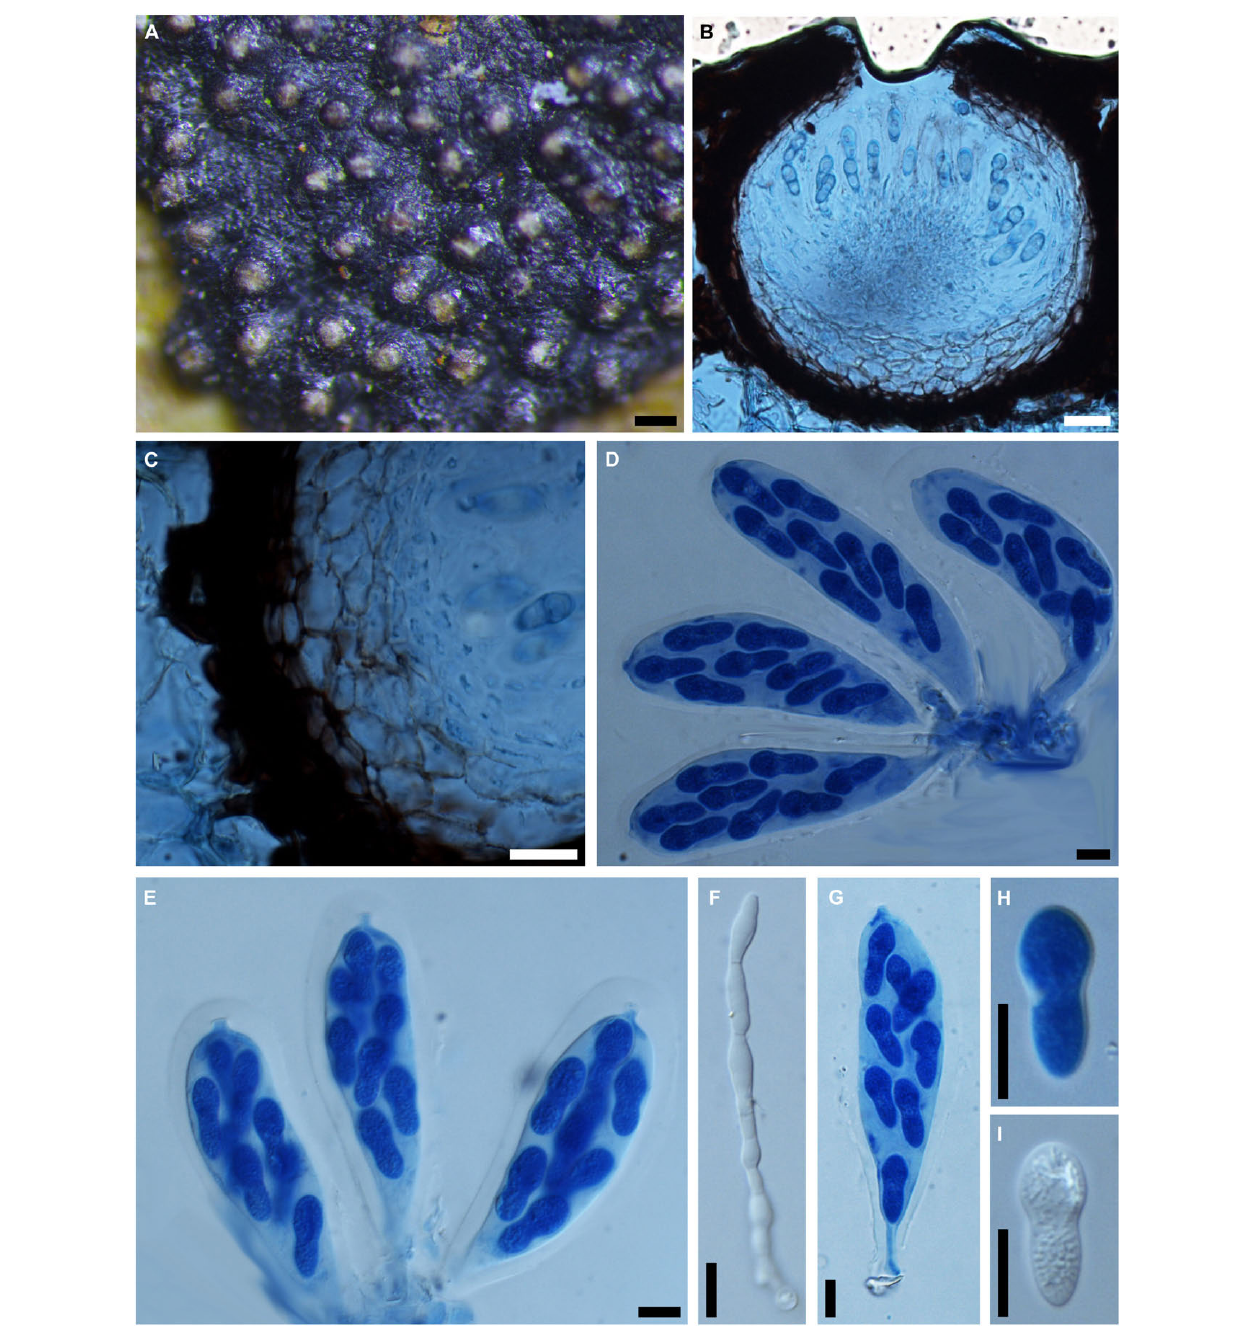
FIGURE 12 | Phyllachorella micheliae (IMI 316002, holotype ). (A) Botryose clusters of ascomata erumpent through the lower side of the leaf. (B) Longitudinal section through an ascoma in cotton blue. (C) Section of the peridium comprising cells of textura angularis in cotton blue. (D,E,G) Squash mounts showing broadly clavate asci with wide ocular chamber near the apex and short pedicels at the base in cotton blue. (F) Septate pseudoparaphyses in water. (H,I) Hyaline, aseptate ascospores in cotton blue (H) or in water (I) . Scale bars: (A) = 100 µ m, (B) = 20 µ m, (C-I) = 20 µ m.